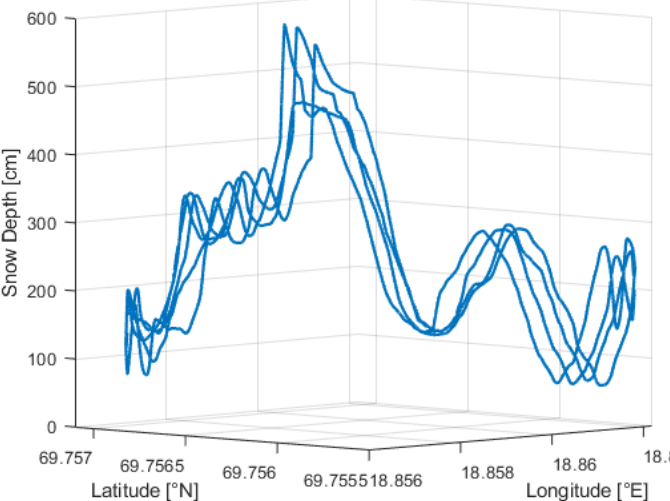
Figure 6. Depth measurements along transect for four passes.